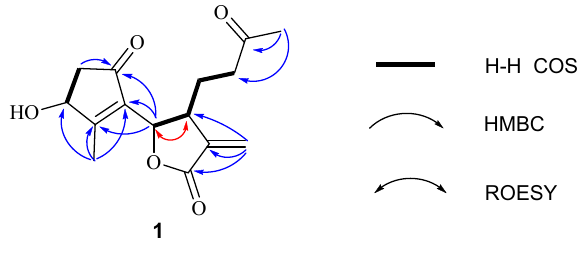
Figure 2. Key correlations of compound 1 .